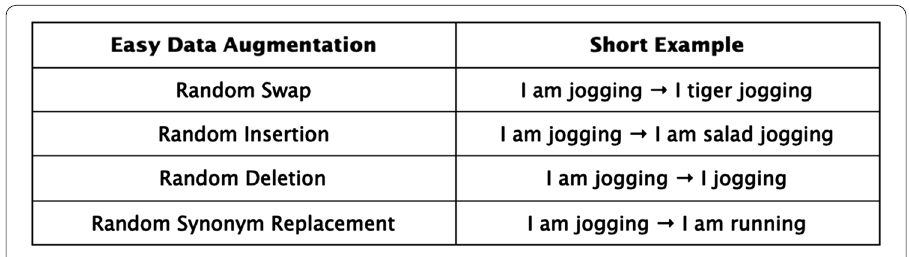
Fig. 2 Examples of easy data augmentation